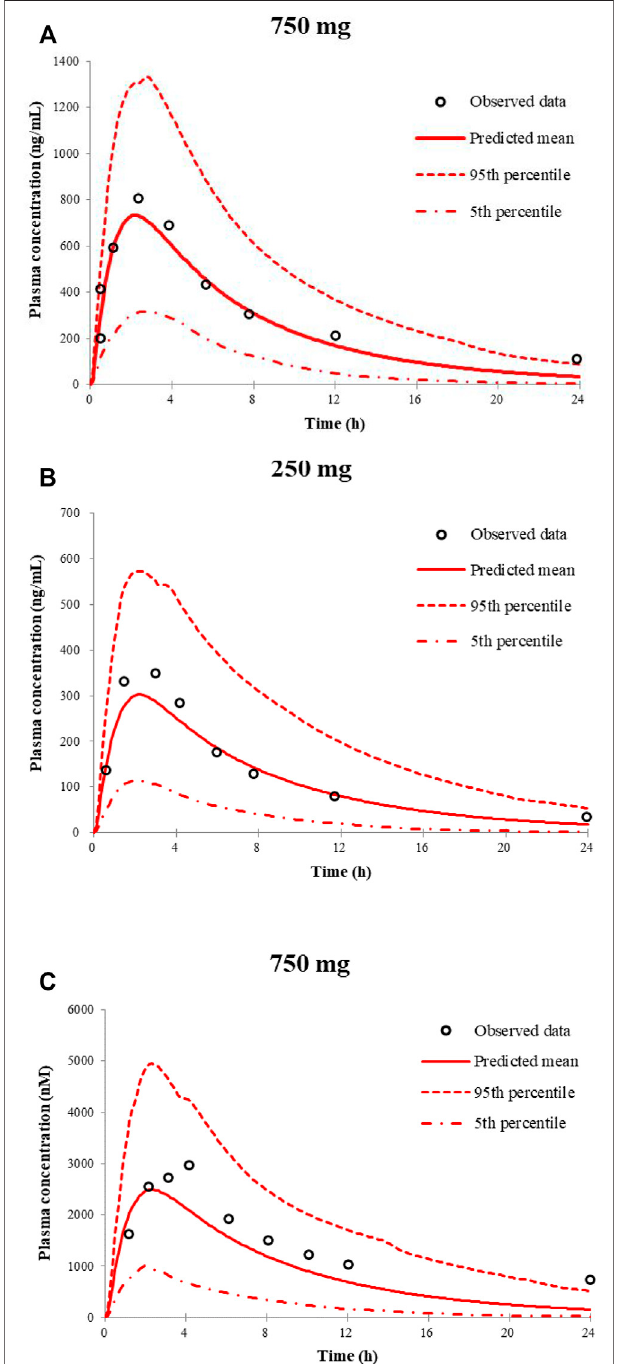
FIGURE 1 | Predicted and observed mean plasma concentration – time curves of apatinib following a single oral dose of apatinib mesylate tablet in healthy volunteers (A , B) and in cancer patients (C)